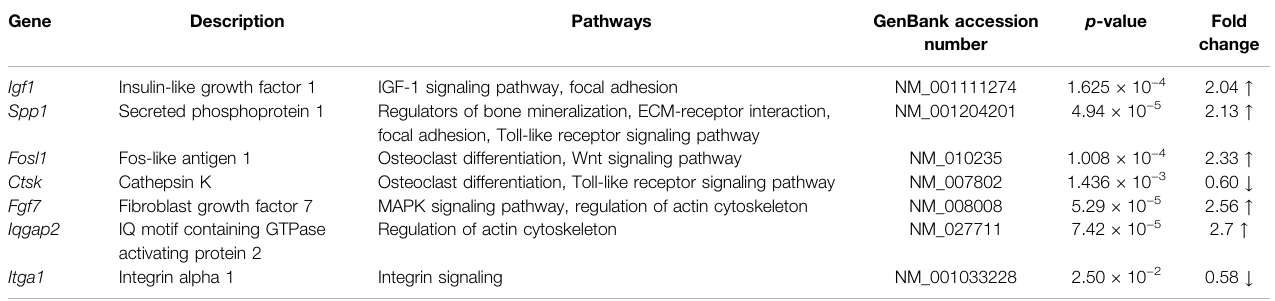
TABLE 3 | Selected differentially regulated bone remodeling and ECM-associated genes upon vibration treatment in MC3T3-E1 cells under estrogen-free conditions. Gene